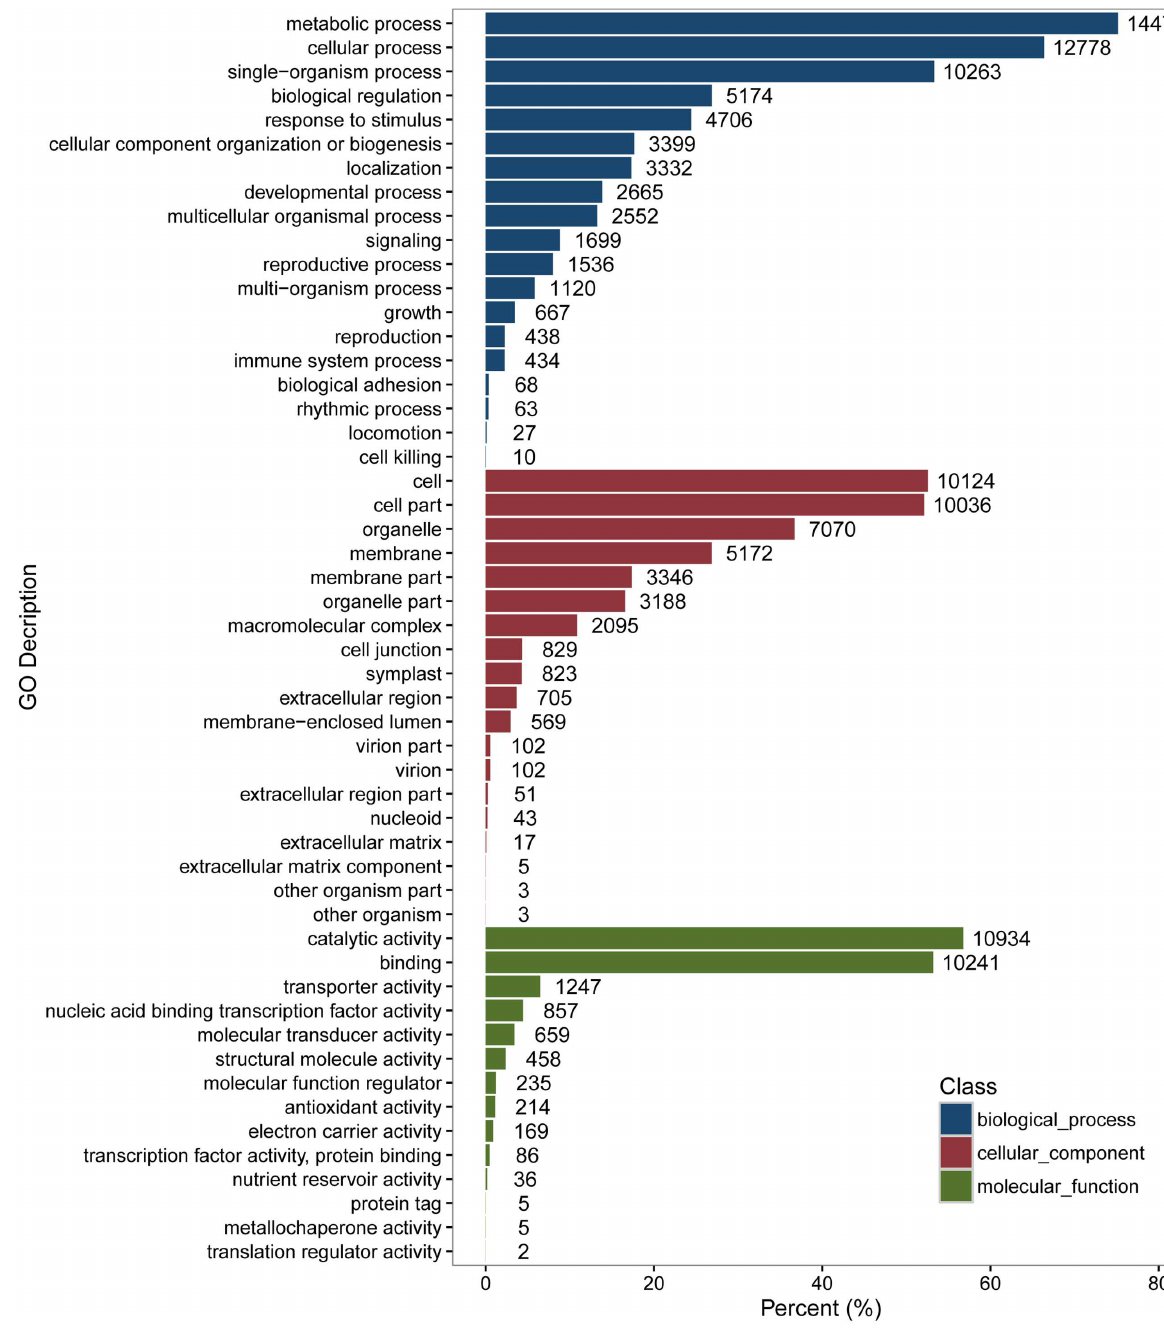
Fig 2. Gene ontology classification of all unigenes at level 2. The number of gene GO terms in each functional subcategory is presented as the percentageof GO terms for that subcategory out of the total GO